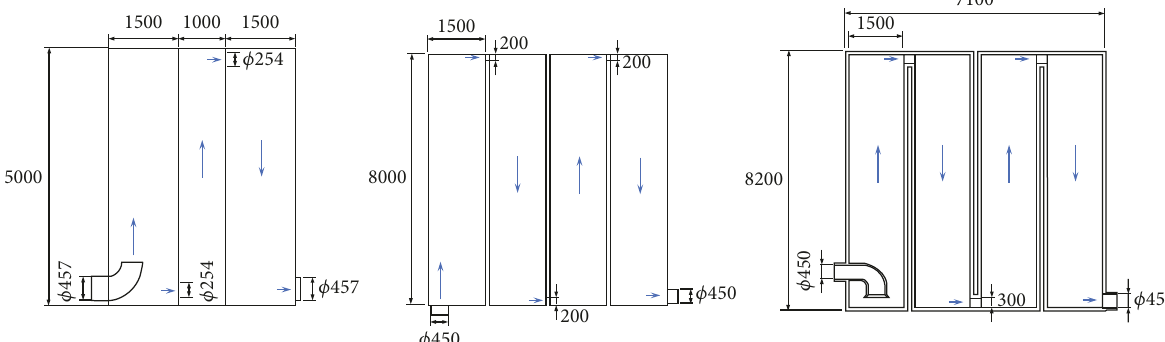
Figure 5: Schematics of first, second, and third decay tank models.